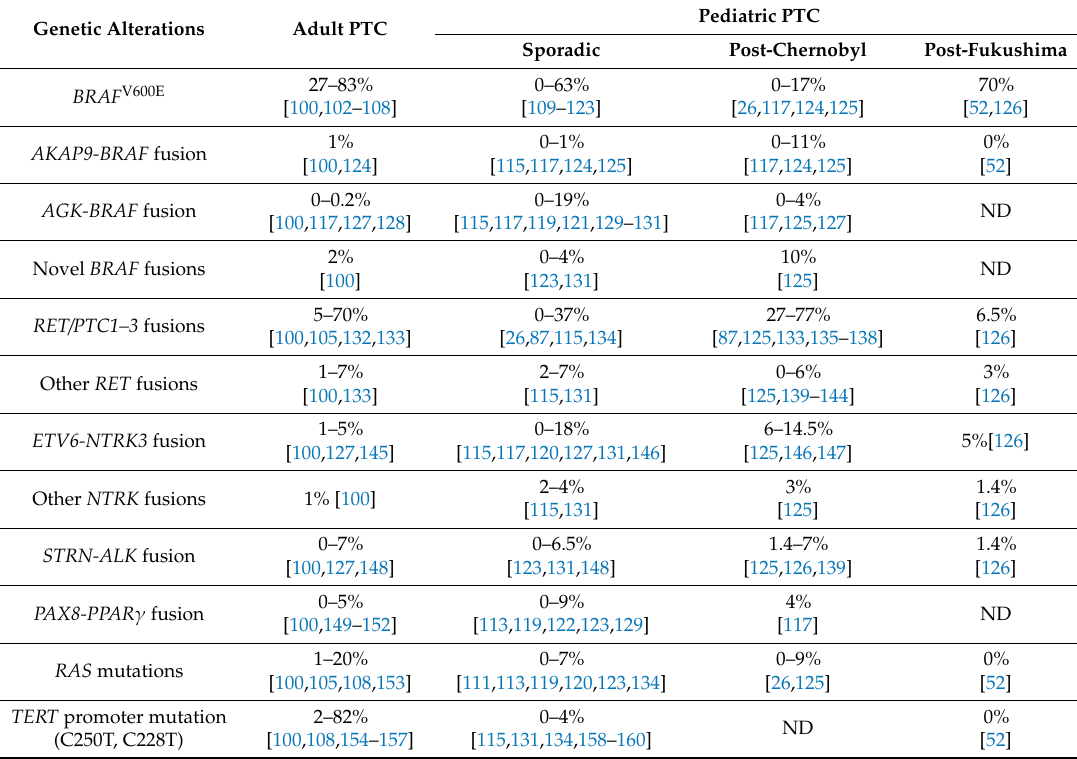
Table 2. Most prevalent genetic alterations described in adult and pediatric